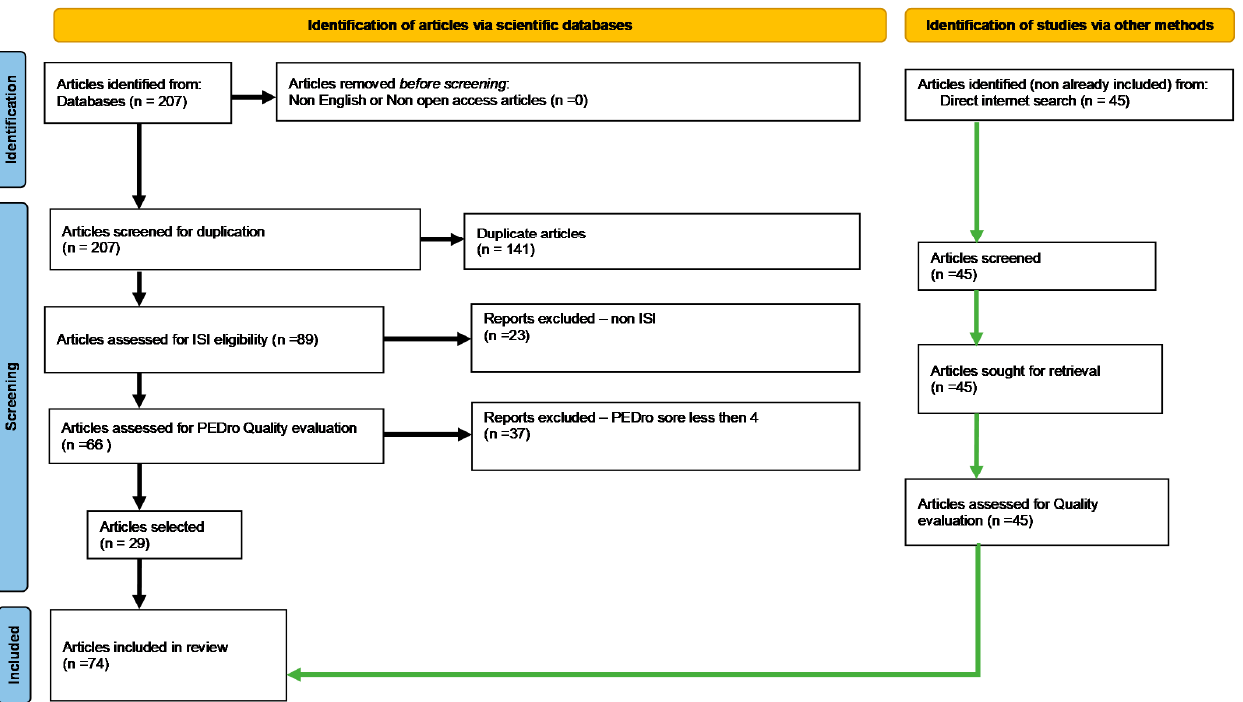
Figure 1. PRISMA-type flow diagram for searching free full-text available papers (ISI eligibility– articles published in ISI-Web-of-Science-indexed journals).